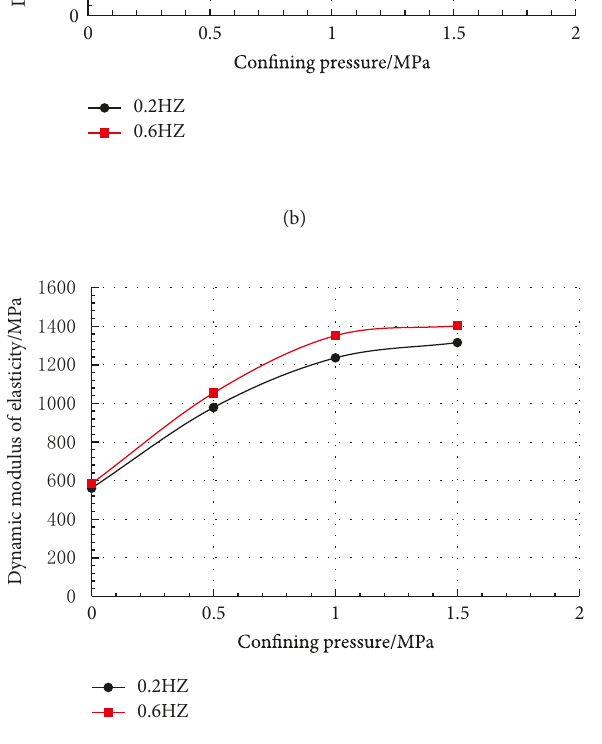
(c) 5 ° C. (b) T 10 ° C. (c) T (cid:31) (cid:31) − −